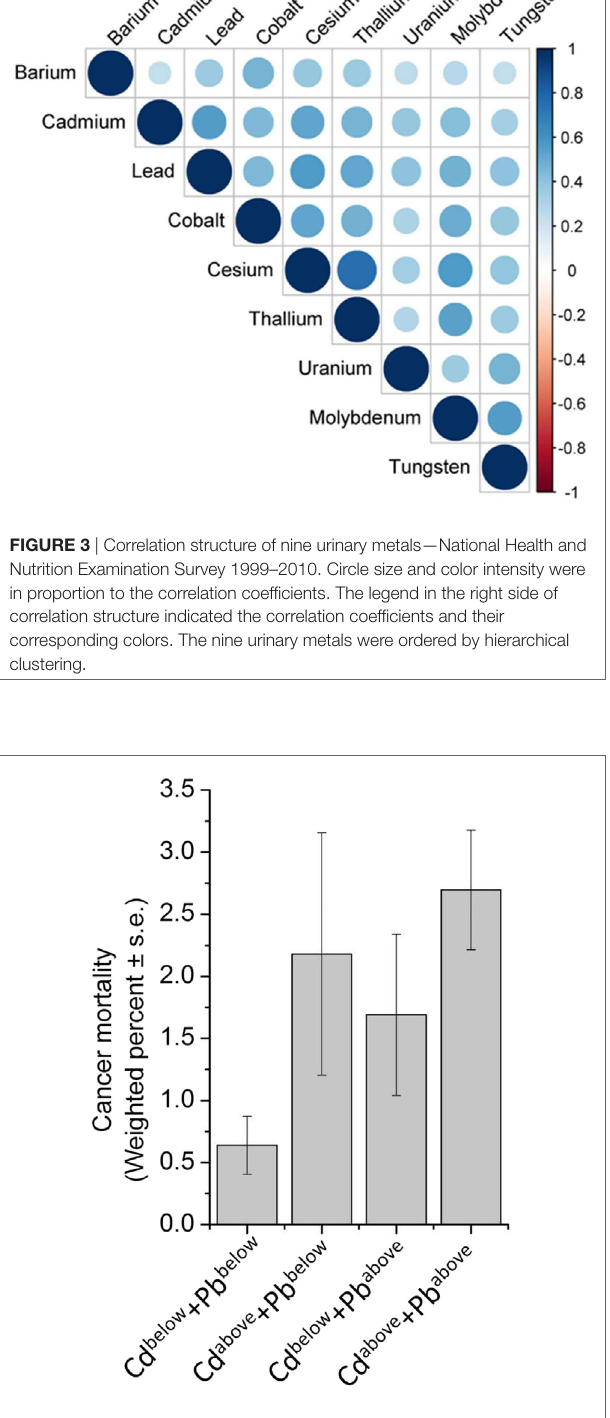
FigUre 4 | Weighted prevalence of cancer mortality according to Cadmium (Cd) and Lead (Pb) levels—National Health and Nutrition Examination Survey 1999–2010. For Cd, below the median: ≤ 0.350 μ g/L; above the median: > 0.351 μ g/L. For Pb, below the median: ≤ 0.68 μ g/L; above the median: > 0.69 μ g/L.